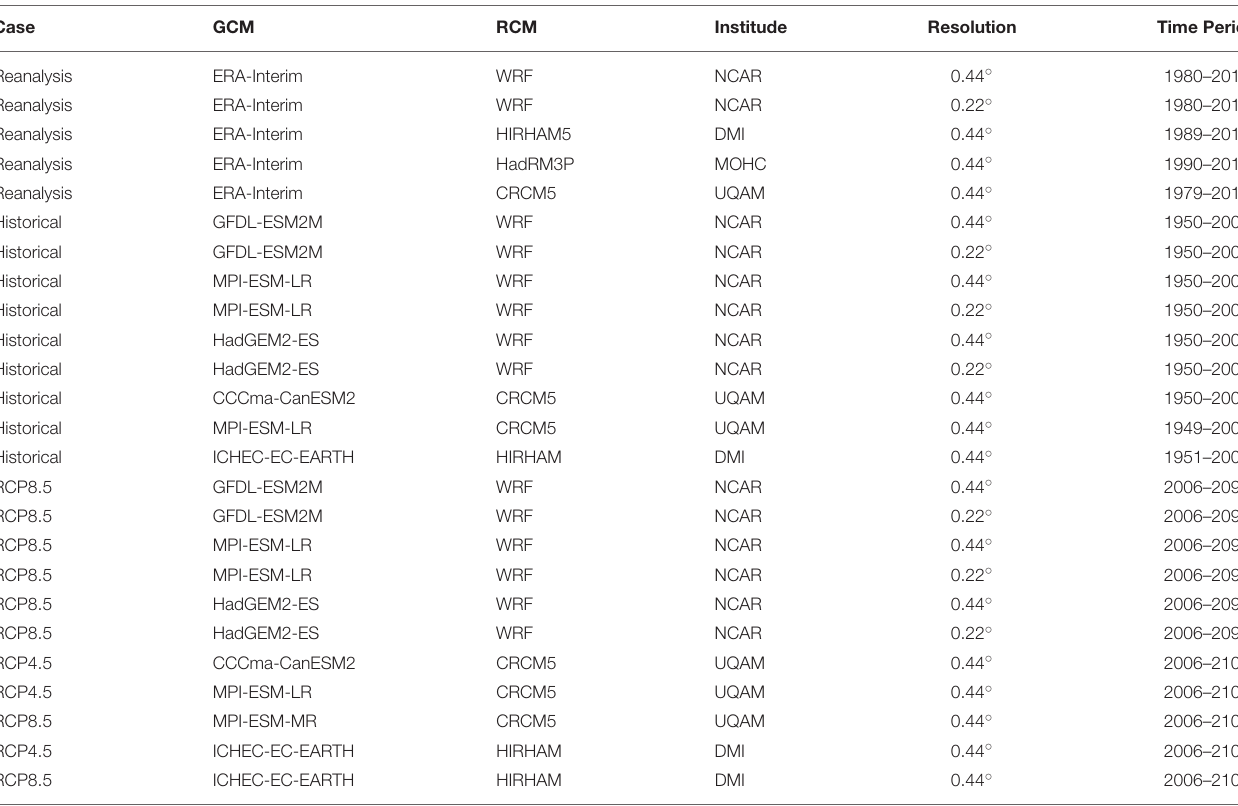
TABLE 1 | NA-CORDEX simulations used in this manuscript.